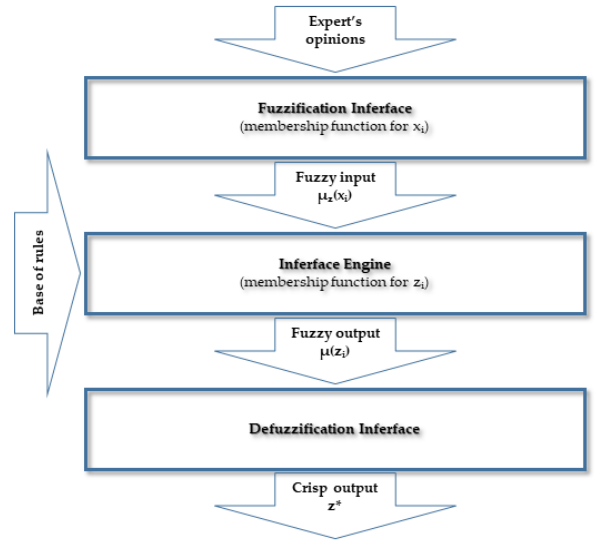
Figure 5. Diagram of the implemented Mamdani fuzzy model.